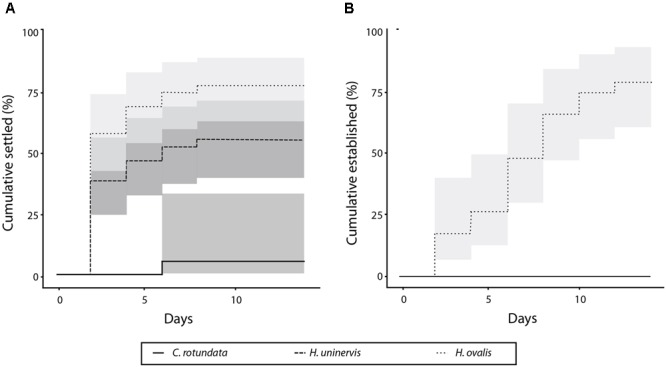
Percent of fragments settled (A) and established (B) over 14 days for each species.